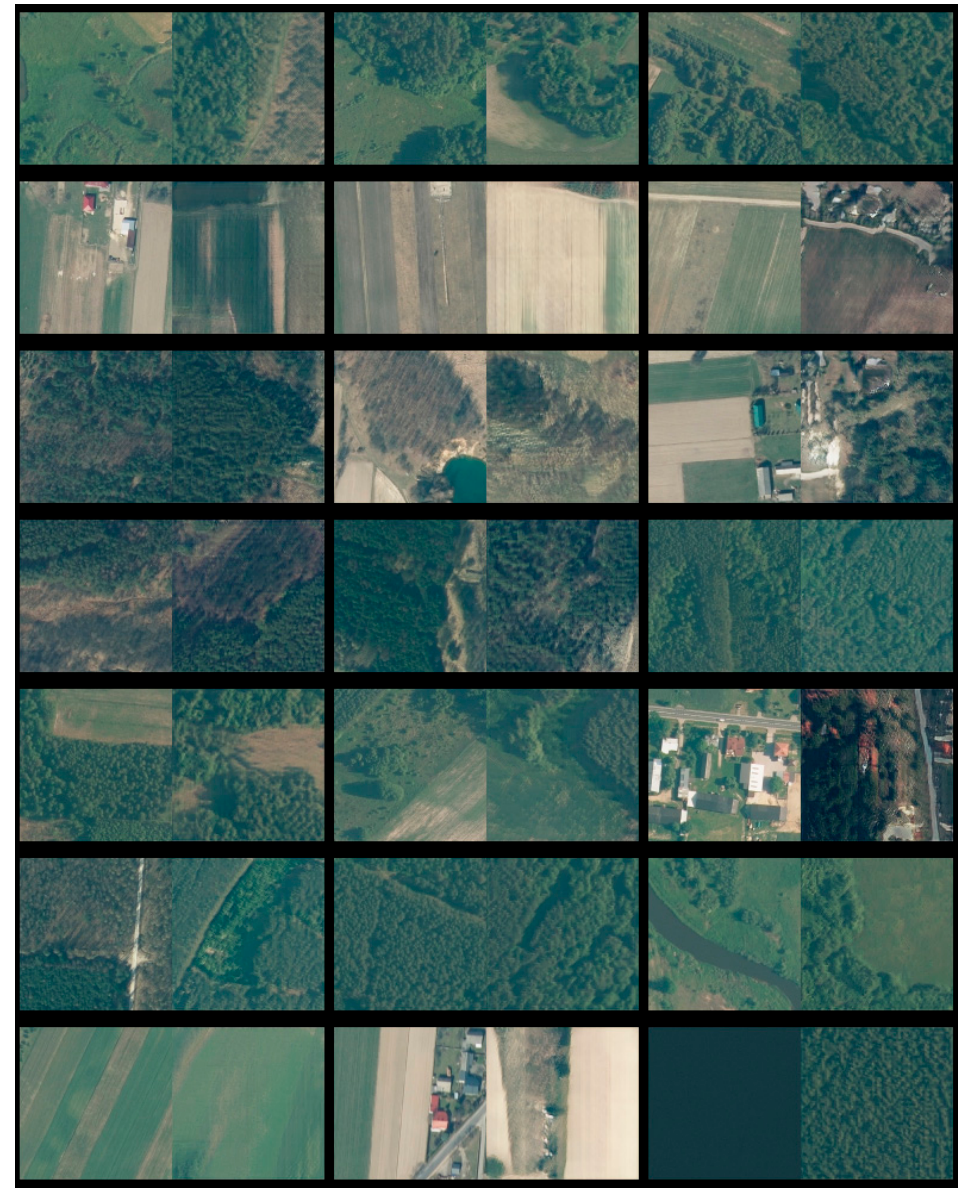
Figure 6. Reconstruction result of 21 validation samples. Ground truth is represented by real tile images placed on the left. Images on the right were reconstructed by the generator from real images latent codes acquired through the encoder.